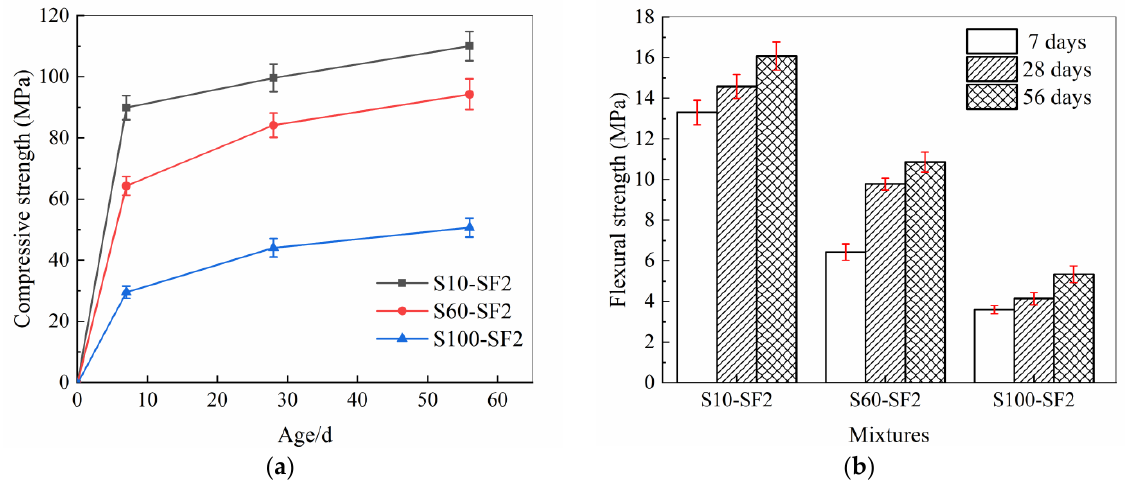
Figure 9. Effects of a massive content of silicomanganese slag on compressive strength ( a ) and flexural strength ( b ) of AASSC.